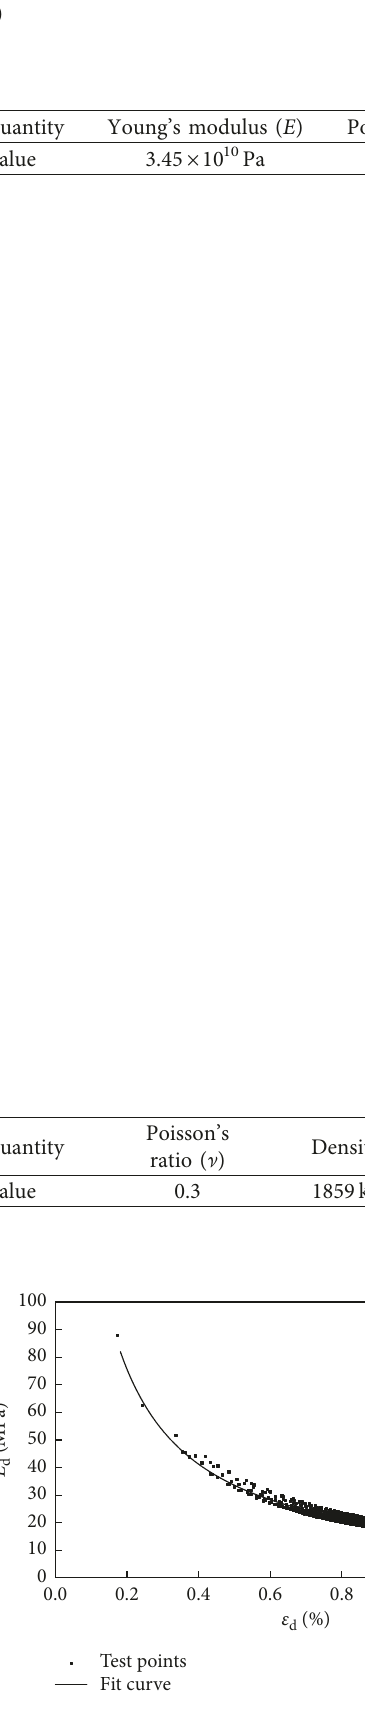
Figure 16: The relationship between dynamic elastic modulus and dynamic